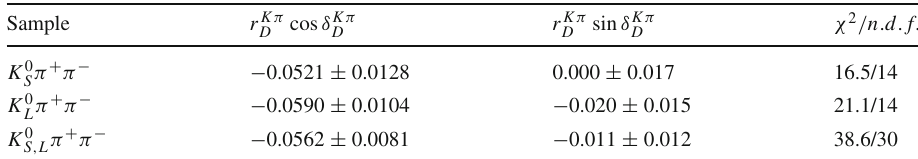
for different fit configurations as described in D